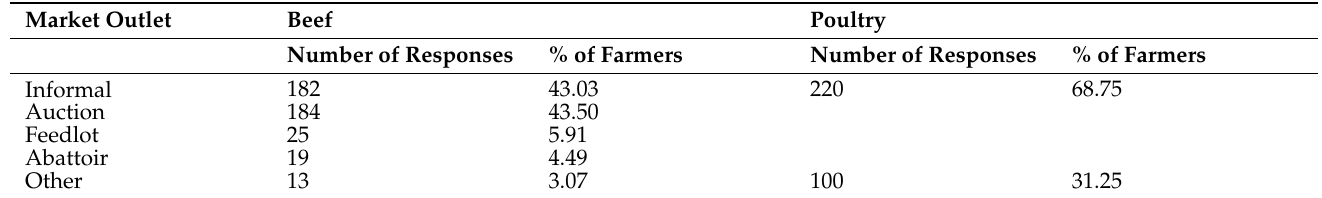
Table 3. Distribution of beef farmers according to place and number of market